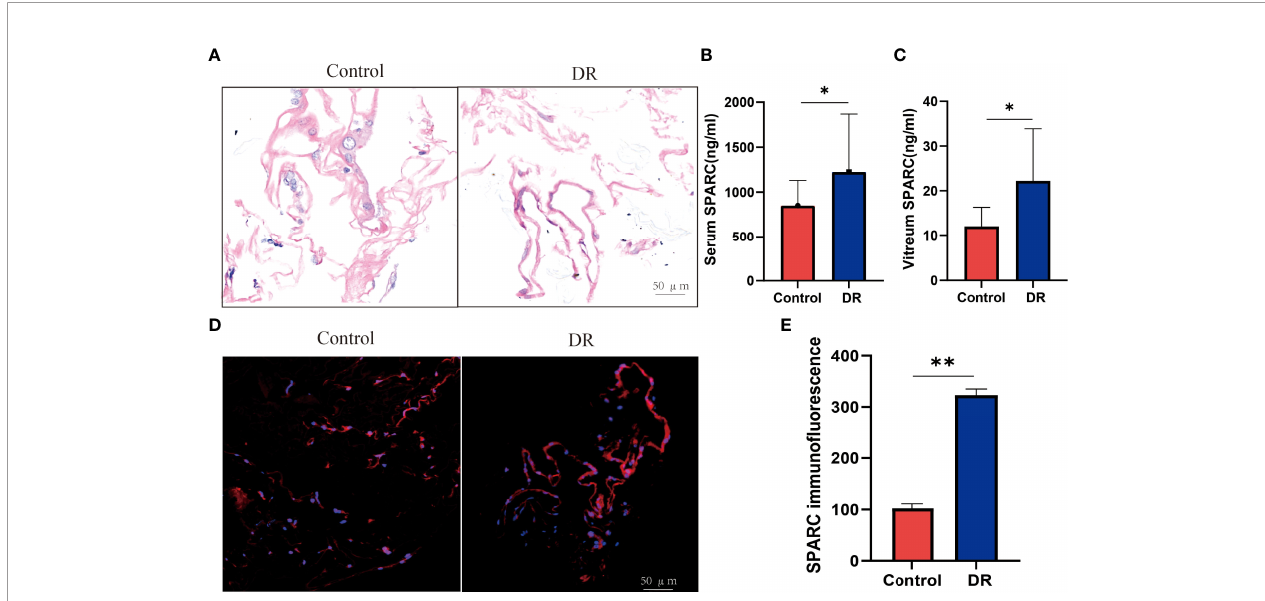
FIGURE 1 | The SPARC level is increased in diabetic retinopathy patient. (A) HE staining. (B, C) Serum and vitreum SPARC level. (D, C) Immuno fl uorescence staining of SPARC in control and diabetic retinopathy patient. (E) SPARC immuno fl uorescence between Control and DR group. * p < 0.05,** p <